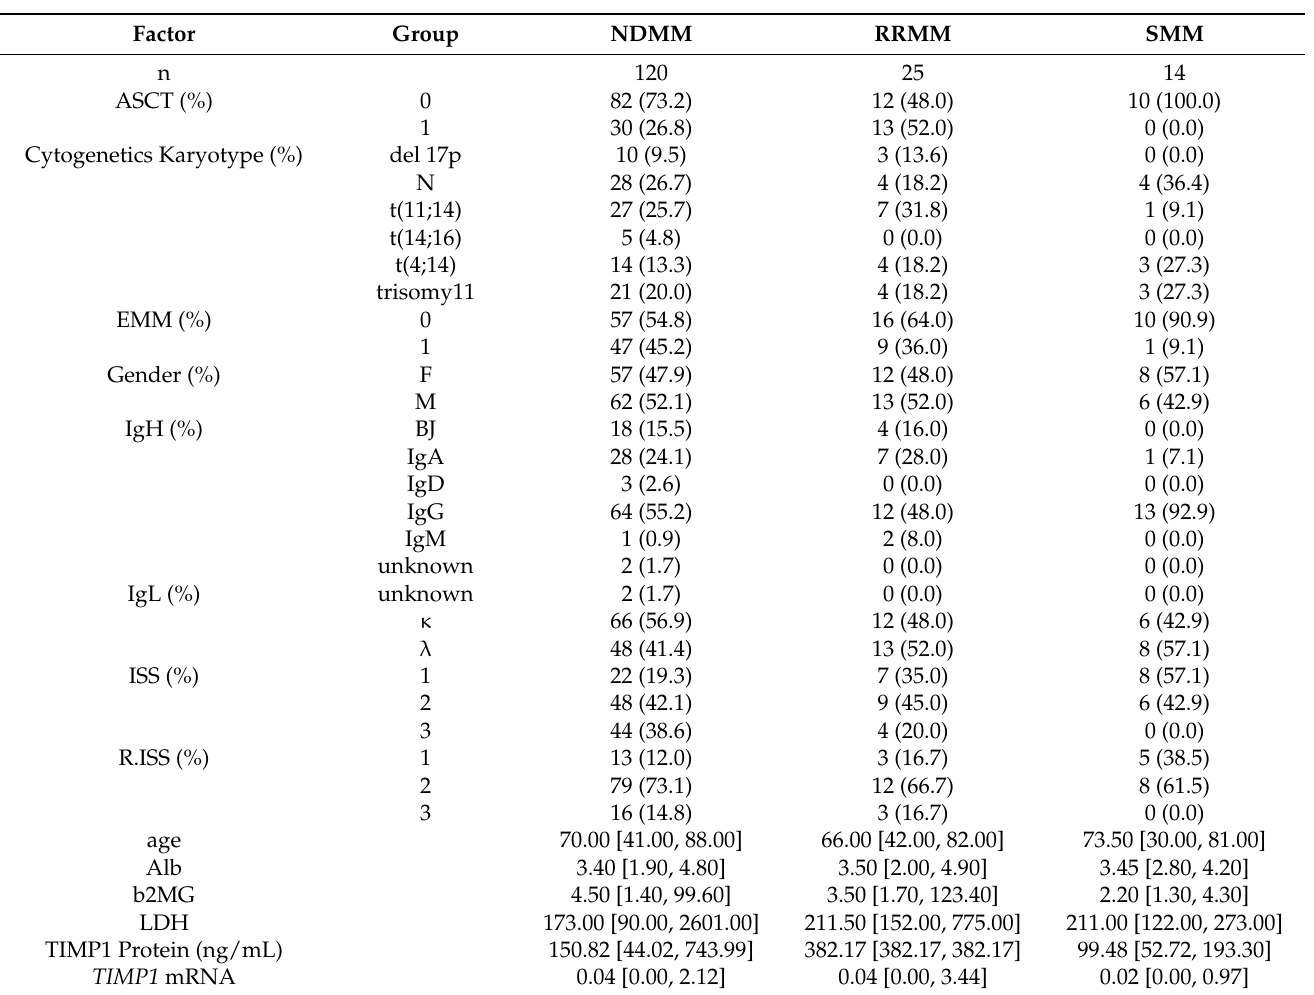
Table 2. Patient characteristics of the 159 MM study